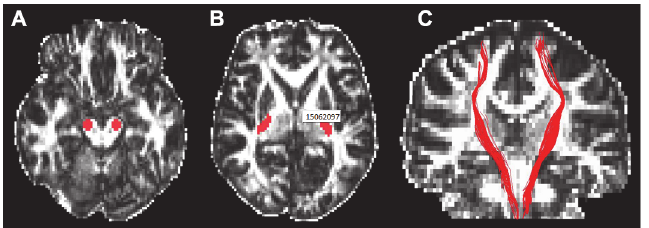
Fig 2. Locations of the seed regions of interest for tracing the corticospinal tract (A and B) and demonstration of the corticospinal tract (C) overlaied on the fractional anisotropy